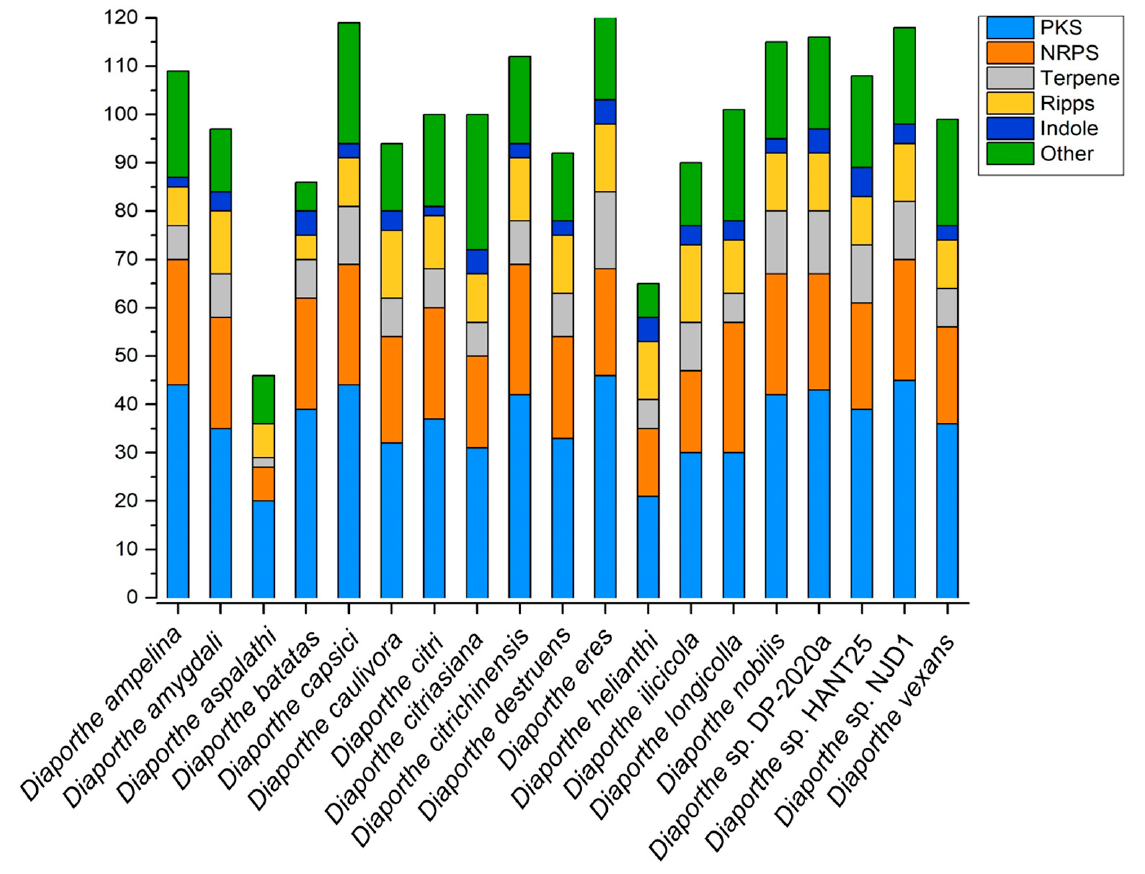
Figure 12. The number ( y -axis) and type of secondary-metabolite BGCs in Diaporthe strains deposited in the NCBI database.